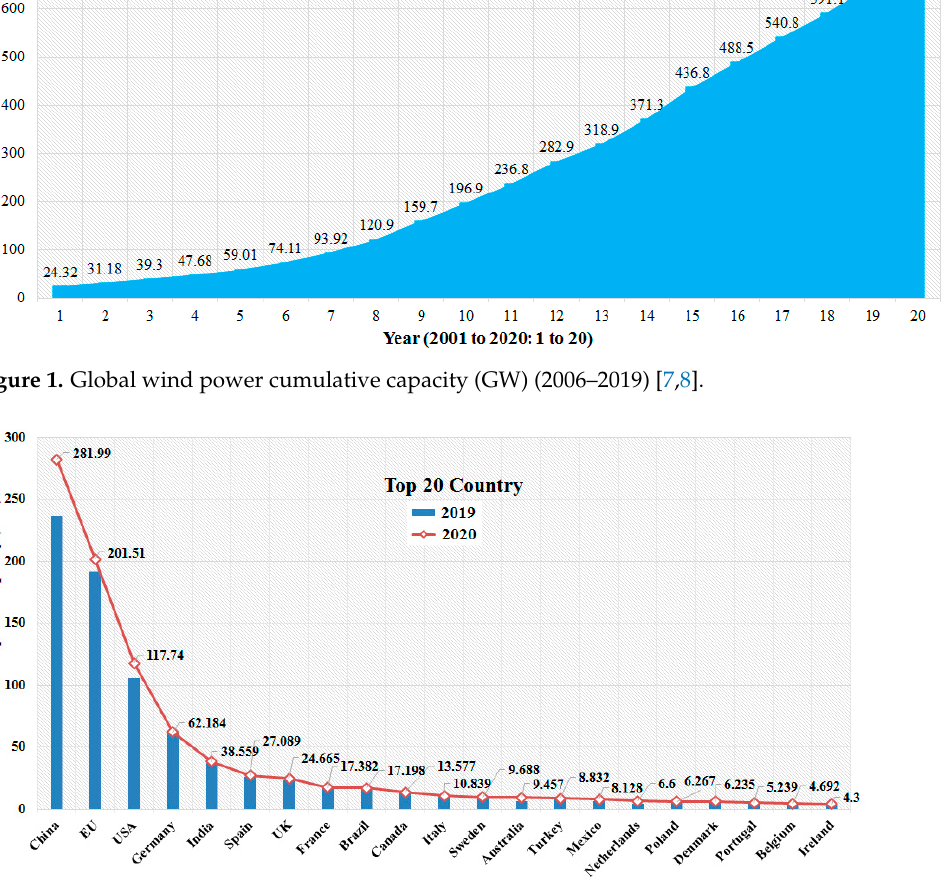
Figure 2. Cumulative installed capacity (CIC) of wind power (MW) 2020 [7,11].